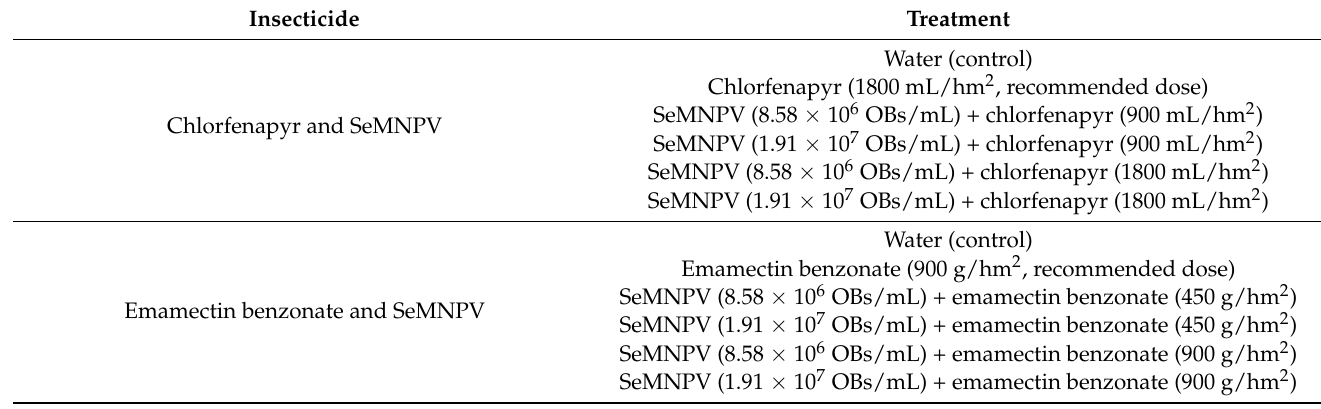
Table 2. Treatments designed for the field trial.